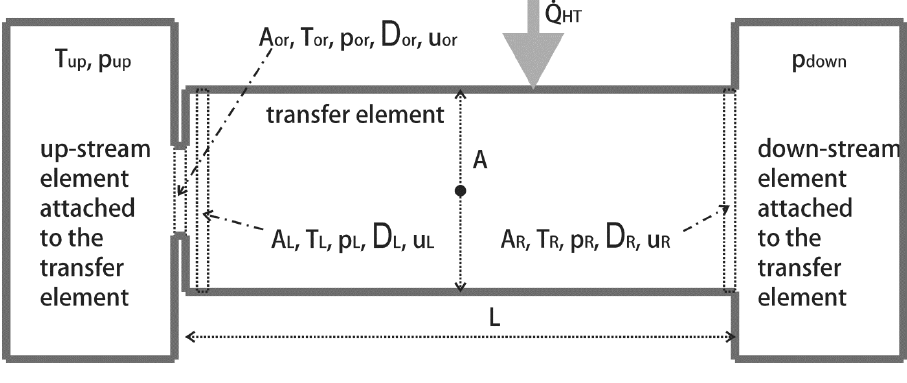
Figure 1. Scheme of the transfer element consisting of the orifice followed by the element of the length L , which in the case of the TMB represents the inertia of the flow